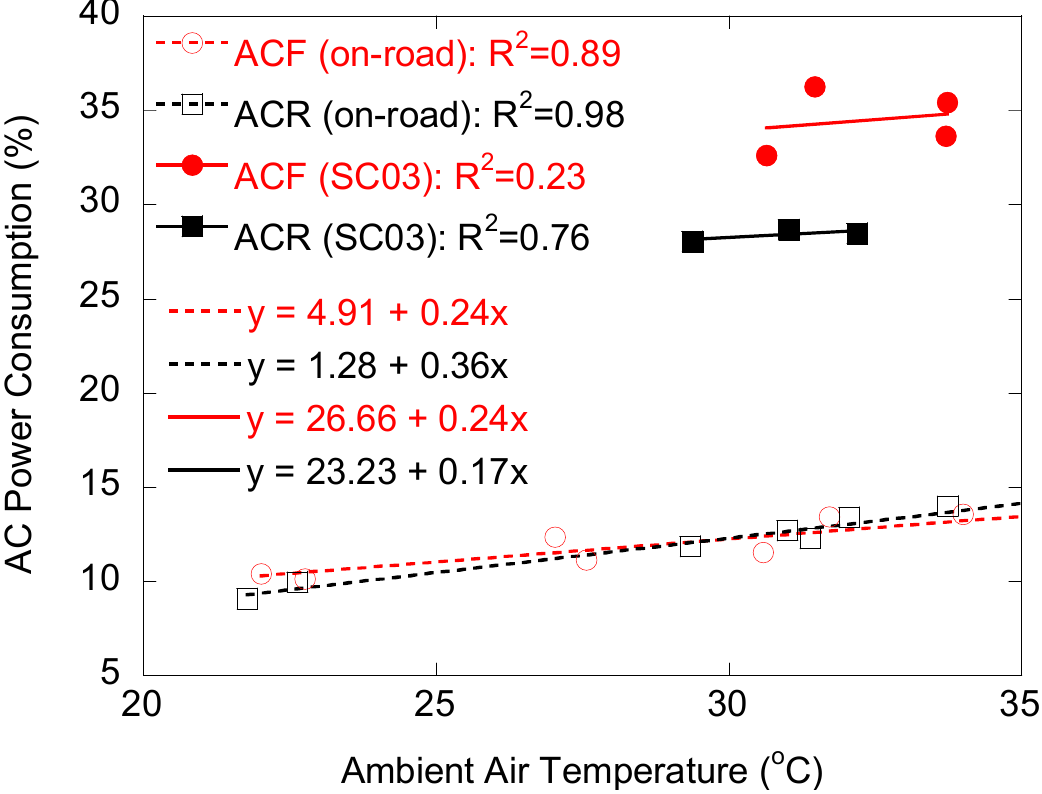
Figure 5. AC power consumption (%) in relation to total power consumption of on-road and SC03 drive cycles .